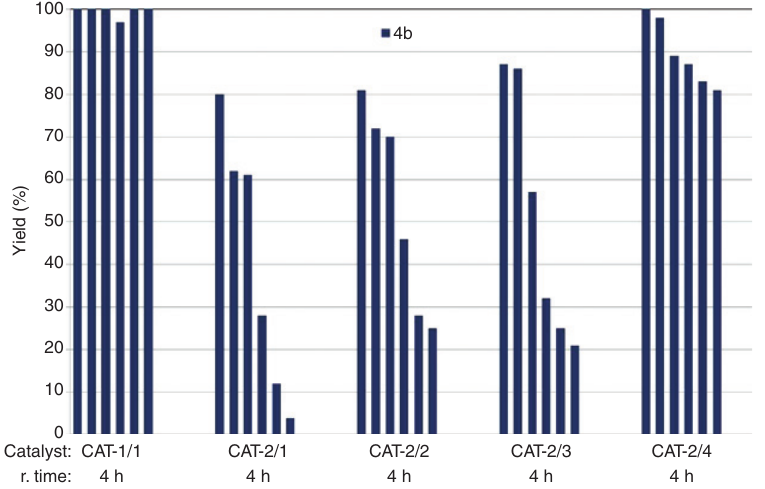
Figure 9: Recyclability of catalysts in aminocarbonylation of iodobenzene ( 1 ) with aniline ( 2b ) at 30 bar [0.2 mmol 1 , 0.5 mmol 2b , 0.7 mmol Et N, catalyst (with 6 μ mol Pd-content), 1 ml DMF, 30 bar CO, 100 ° C]. 3